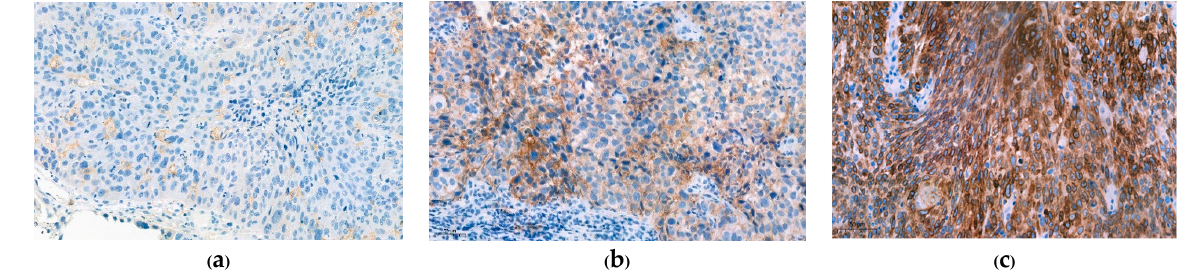
Figure 2 . Immunohistochemical staining for CD8 ( 100× ). ( a ) CD8 > 1 % but < 5 % ; ( b ) CD8 > 5 % but <10 % ; Figure 3 . Immunohistochemical staining for PD - L1 ( 200× ). ( a ) CPS > 1 but < 20 with weak intensity ( 1 +) ; ( c ) CD8 > 10 %. ( b ) CPS > 20 with moderate intensity ( 2 +) ; ( c ) CPS > 20 with strong intensity ( 3 +).